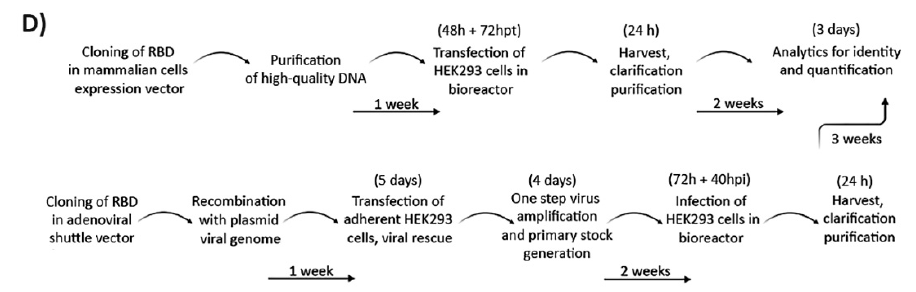
Figure 1. Genetic construction design of SARS-CoV-2 RBD expression cassettes and detection of the recombinant protein by transient transfection and adenoviral infection of HEK293SF cells. ( A ) Schematic representation of constructions encoding the RBD preceded by the native Spike signal peptide (SP) or the human Plasminogen Tissue Activator (hTPA) secretion signal, followed by a polyhistidine tag (6xHis). The coding sequence for the bacterial Sortase A coupling peptide (SrtA, CP) was added at the C-terminal of the protein. The diagram shows the regulatory regions that control the expression of RBD: (i) a fragment of the human cytomegalovirus enhancer / promoter (hCMV) was used in all the constructions, (ii) the rabbit β -globin polyA signal was used in the plasmid constructions for transient transfection, and the SV40 polyA fragment in the adenoviral constructions. ( B ) Detection by Western Blot of RBD expression in 25 mL of culture supernatant 72 h post-transfection (hpt) in shake flasks using HyCell TransFx-H medium. An anti His-tag monoclonal antibody was used. The secreted antigen is detected with an apparent molecular weight of approximately 38 kDa. Lanes 1, 2 correspond to the protein expressed under the native Spike signal peptide and lanes 3, 4 to secretion driven by the hTPA secretion signal. In lanes 2 and 4, (5X) corresponds to a 5-fold concentration of culture supernatant. Equal amounts of total proteins (3.6 ug for lanes 1 and 3 and 12.6 ug for lanes 2 and 4) were loaded onto the gel, enabling to confirm that higher RBD secretion levels were obtained with the use of the hTPA signal peptide. ( C ) Detection by Western blot of RBD expression mediated by adenoviral infection of HEK293SF cells. The anti His-tag monoclonal antibody (lanes 1–3) and a polyclonal anti-SARS-CoV-2 Spike antibody (4–7) were used. The protein was similarly expressed with a molecular weight of about 38 kDa. The polyclonal antibody used showed non-specific binding to one protein identified as lactoferrin, present in the culture medium at a molecular weight of approximately 75 kDa. Lanes 2, 4and 3, 5 show the expression of RBD using the native signal peptide and hTPA, respectively, at the time of harvest, 40 h post-infection, as recognized with each antibody. Lanes 6 and 7 correspond to detection of RBD under the two signal peptides in HEK293 adherent cells at the time of virus rescue (note no presence of lactoferrin at 75 kDa when using DMEM + 10%FBS). Lane 1 in ( C ) corresponds to RBD used as positive control, as referenced in Materials and Methods. ( D ) Diagram representing the workflow and timelines for the accelerated production of RBD following the two methods described.